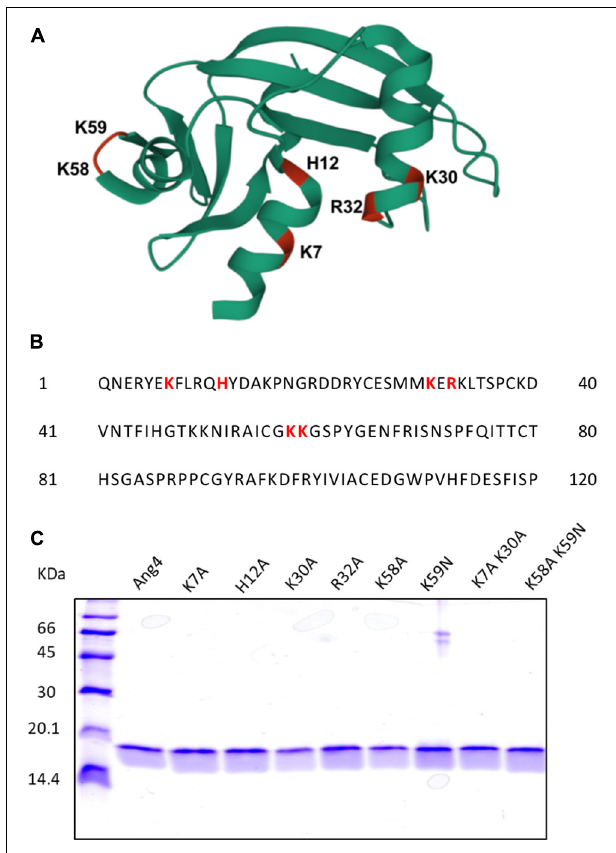
FIGURE 1 | Structural overview and generation of WT and Mutant Angiogenin 4. (A) 3D structure of Ang4 (PDB entry 2J4T). The mutated residues in this study are highlighted in color and labeled. (B) Amino acid sequence of Ang4. (C) SDS-PAGE of purified WT Ang4 and its mutants. Proteins were electrophoresed on a 15% polyacrylamide gel and stained with the Coomassie Brilliant Blue R-250